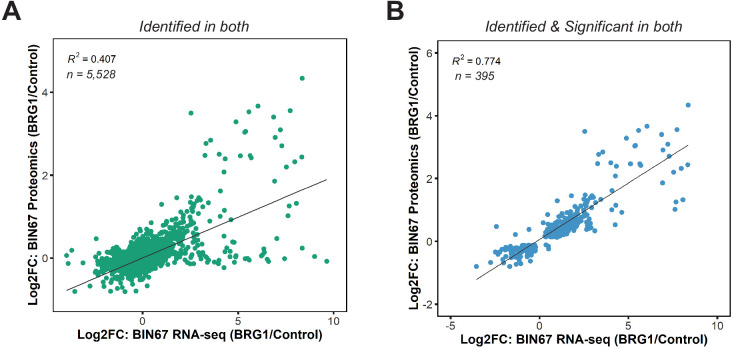
Correlation of RNA-seq and proteomics data in BIN67 cells.(A) Scatterplot of gene expression changes and protein expression changes for proteins and genes identified in both (n = 5528). For instances where multiple proteins mapped to a particular gene, the average log2foldchange of protein abundance was calculated. (B) Scatterplot of gene expression changes and protein expression changes for proteins and genes identified as significant in both (RNA-seq: padj <0.05, Proteomics: FDR < 0.05). For instances where multiple proteins mapped to a particular gene, the average log2foldchange of protein abundance was calculated.